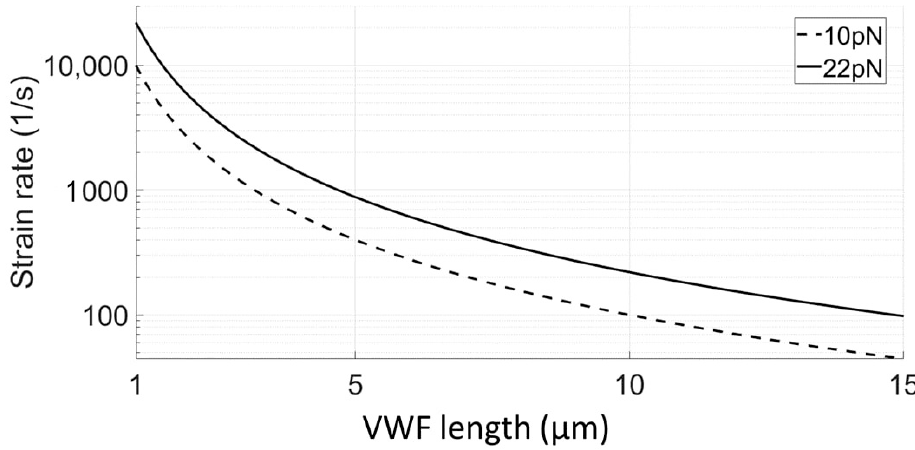
Figure 1. Force applied to VWF in laminar flow for a Deborah number much smaller than 1. Compared to De << 1, De >> 1 exhibits much lower drag force values, as shown in Figure 2 for a large range of strain rates. The maximum drag force for De >> 1 is larger than the critical force to extend VWF, and is far beyond the critical force for A2